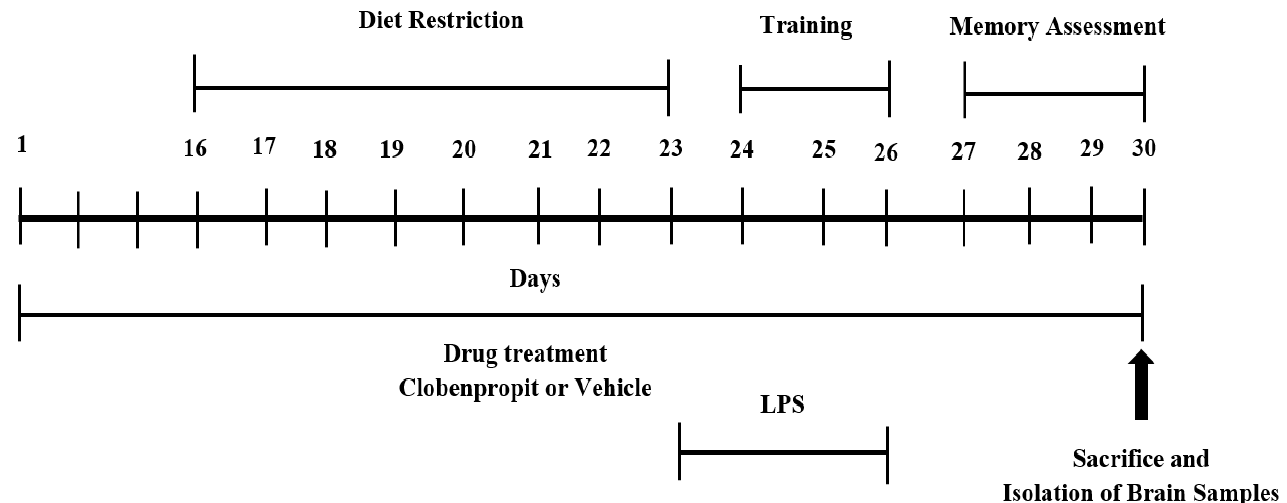
Figure 1. Timeline administration of drug, behavioral assessments, and isolation of brain samples. The groups of the mice were administered vehicle or clobenpropit (1 or 3 mg/kg) orally for 30 days. Except for the control, other groups were injected with four doses of LPS (250 µ g/kg, i.p.) to induce neuroinflammation (days 23–26). Regarding RAM assessments, the training sessions were conducted from days 24 to 26. The memory assessments were analyzed from days 27 to 30. At the end of the memory assessments, on day 30, all the animals were sacrificed and brain tissues were collected for ELISA tests.